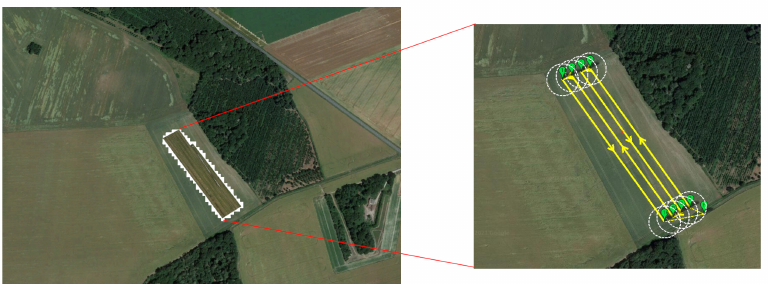
Figure 2. Overlay of the orthophoto on google earth of the spinach plot ( left ) and the flight plan ( right ) across a spinach field (the images are taken along the yellow lines at regular intervals to ensure sufficient overlapping).